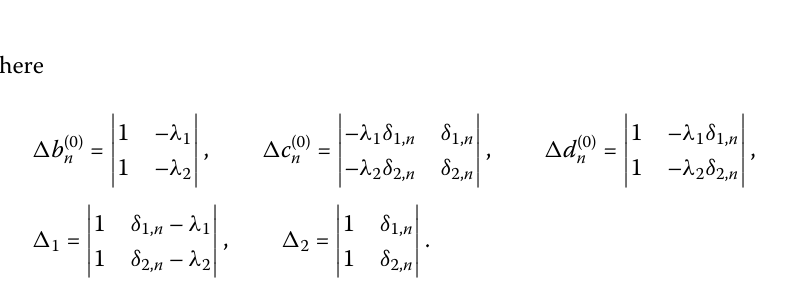
Figure 2 ( a1 )–( c1 ) Dark one-soliton solution (cid:8) u n in (43). ( a2 )–( c2 ) Bright one-soliton solution (cid:8) v n in (43). The same parameters as Fig. 1 except that λ 1 =